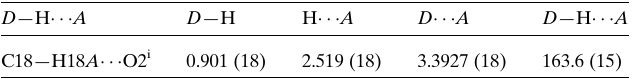
Table 1 Hydrogen-bond geometry (A˚ , (cid:2) ).